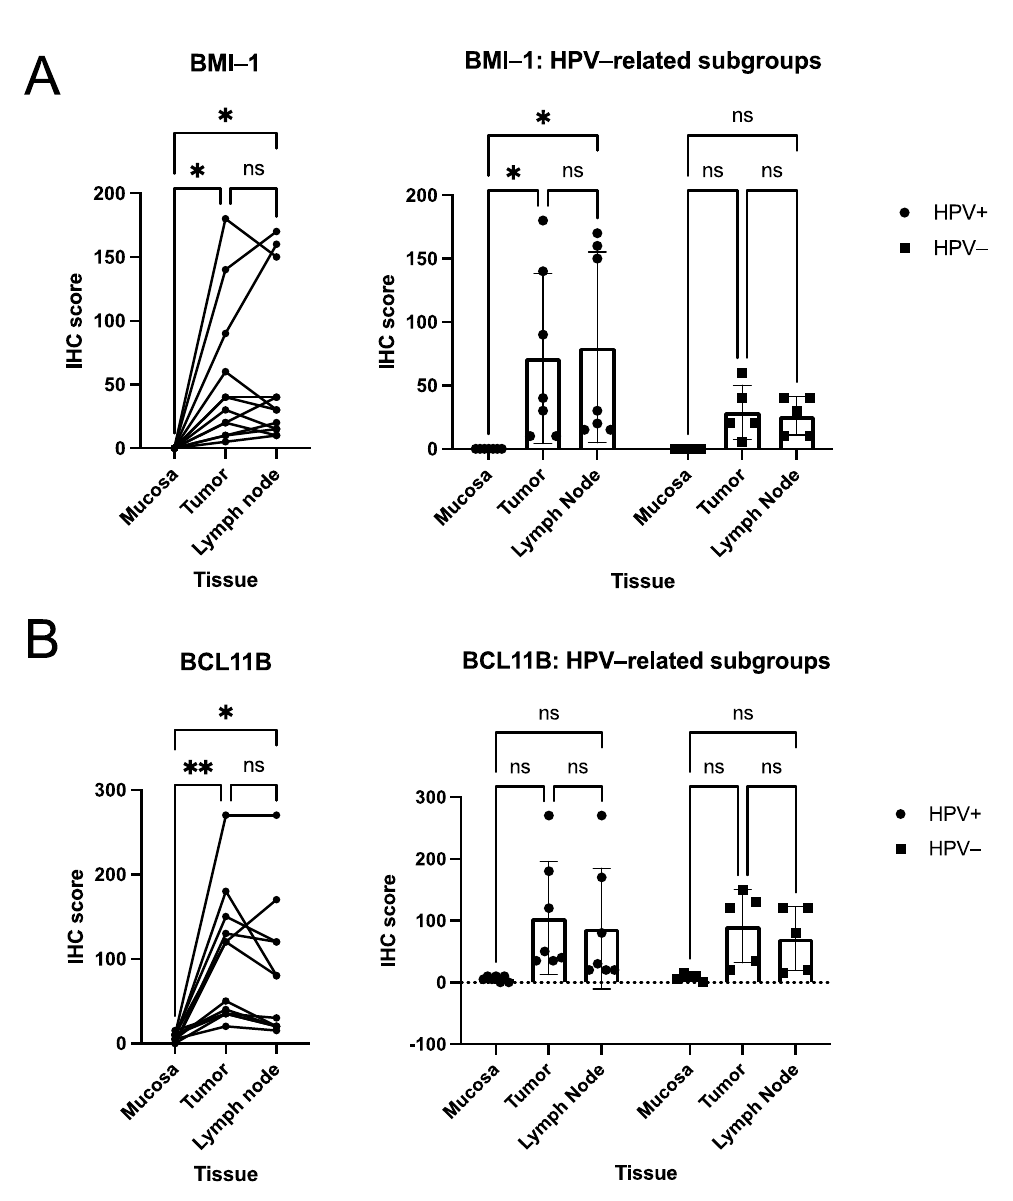
Figure 1. Quantitative analyses of BMI-1 ( A ) and BCL11B ( B ) IHC scores in HNSCC. Connected dots deflect IHC scores of one individual patient in the exploratory analysis of HNSCC patients. Plots show means with SD of data stratified according to HPV-status (HPV-positive versus HPV-negative). p -values (one way RM ANOVA for cohort analyses, two-way RM ANOVA for subcohort analyses) are indicated (* p < 0.05, ** p < 0.01, n.s. p > 0.05).